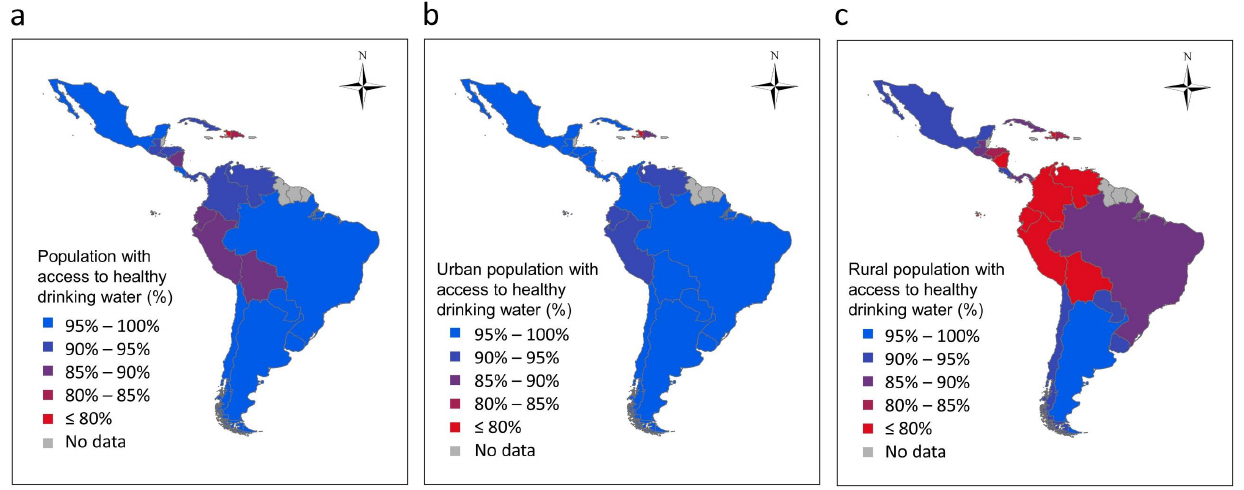
Figure 3. Access to healthy drinking water in Latin America: ( a ) Total population; ( b ) Urban population; and ( c ) Rural population. Source: FAO (2017) [7].